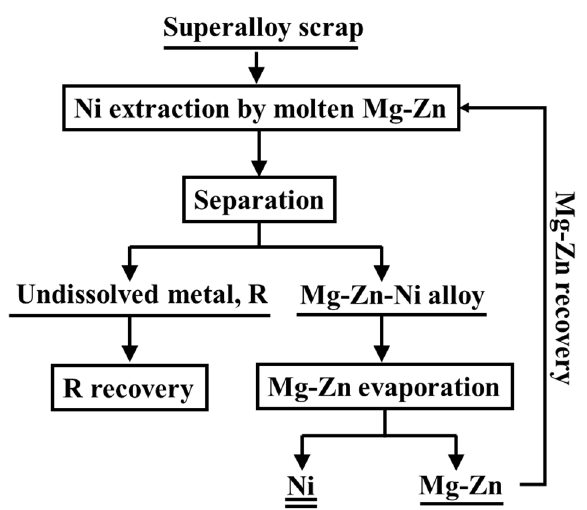
Figure 1. The principle flowsheet of the liquid metal extraction-vacuum distillation (LME-VD) process.